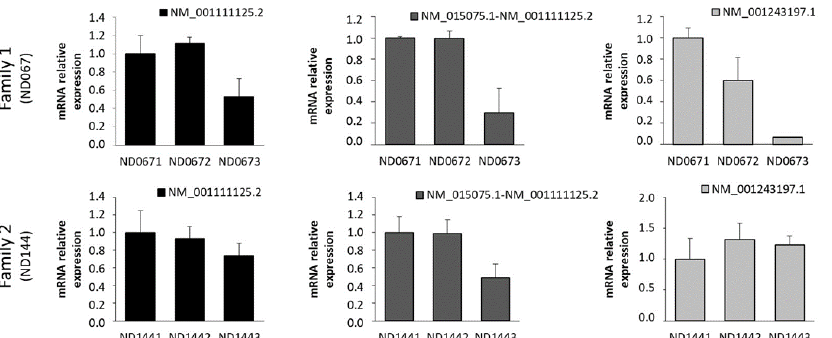
Figure 3. Relative quantification of IQSEC2 transcripts isoforms in the two families. Quantitative QT-PCR expression analysis for IQSEC2 isoforms in ND067 and ND144 families, showing expression levels of patients (ND0673 and ND1443) compared to their fathers (ND0671 and ND1441) and mothers (ND0672 and ND1442). Left panels represent expression levels based on primers amplifying between exons 2 and 3, specific for larger isoform (NM_001111125). Middle panel shows the expression using primers for exons 12–13, which do not discriminate between large and intermediate isoforms. Right panels show the expression of short IQSEC2 isoform (NM_001243197) with a specific assay designed between alternative exons 2 (cid:48) and 3 (cid:48) , only present in this